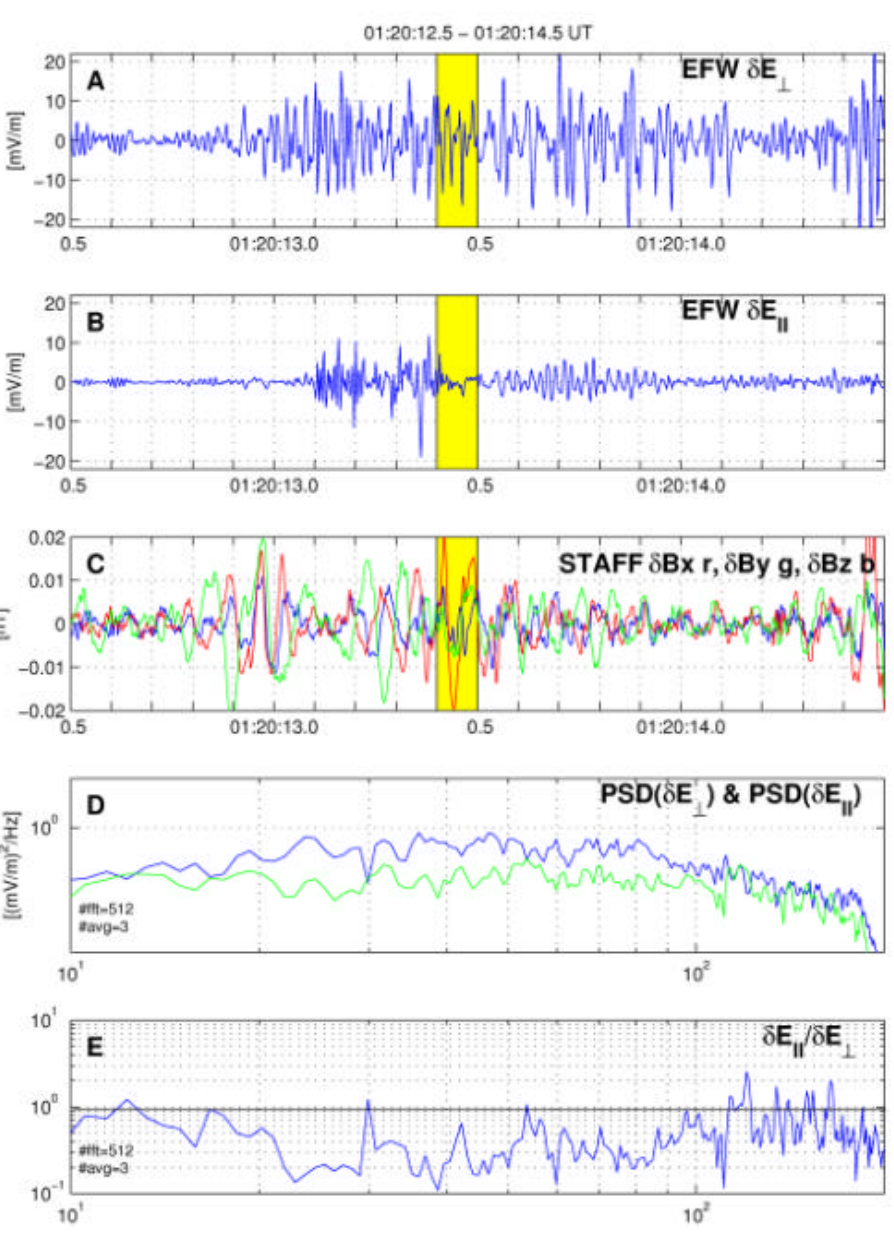
Fig. 3. Data from Cluster spacecraft 2 during part of the interval in Fig. 1: electric field (10–180Hz) perpendicular (panel A ) and parallel (B) to the geomagnetic field; magnetic field (10–180Hz) in the GSE x, y and z-directions (red, green and blue, respectively) (C) , power spectrum of the perpendicular and parallel electric field (D) , and the ratio of the parallel and perpendicular electric field (E) . The perpendicular component often dominates, which is typical. The interval indicated in yellow is studied in detail in Fig.